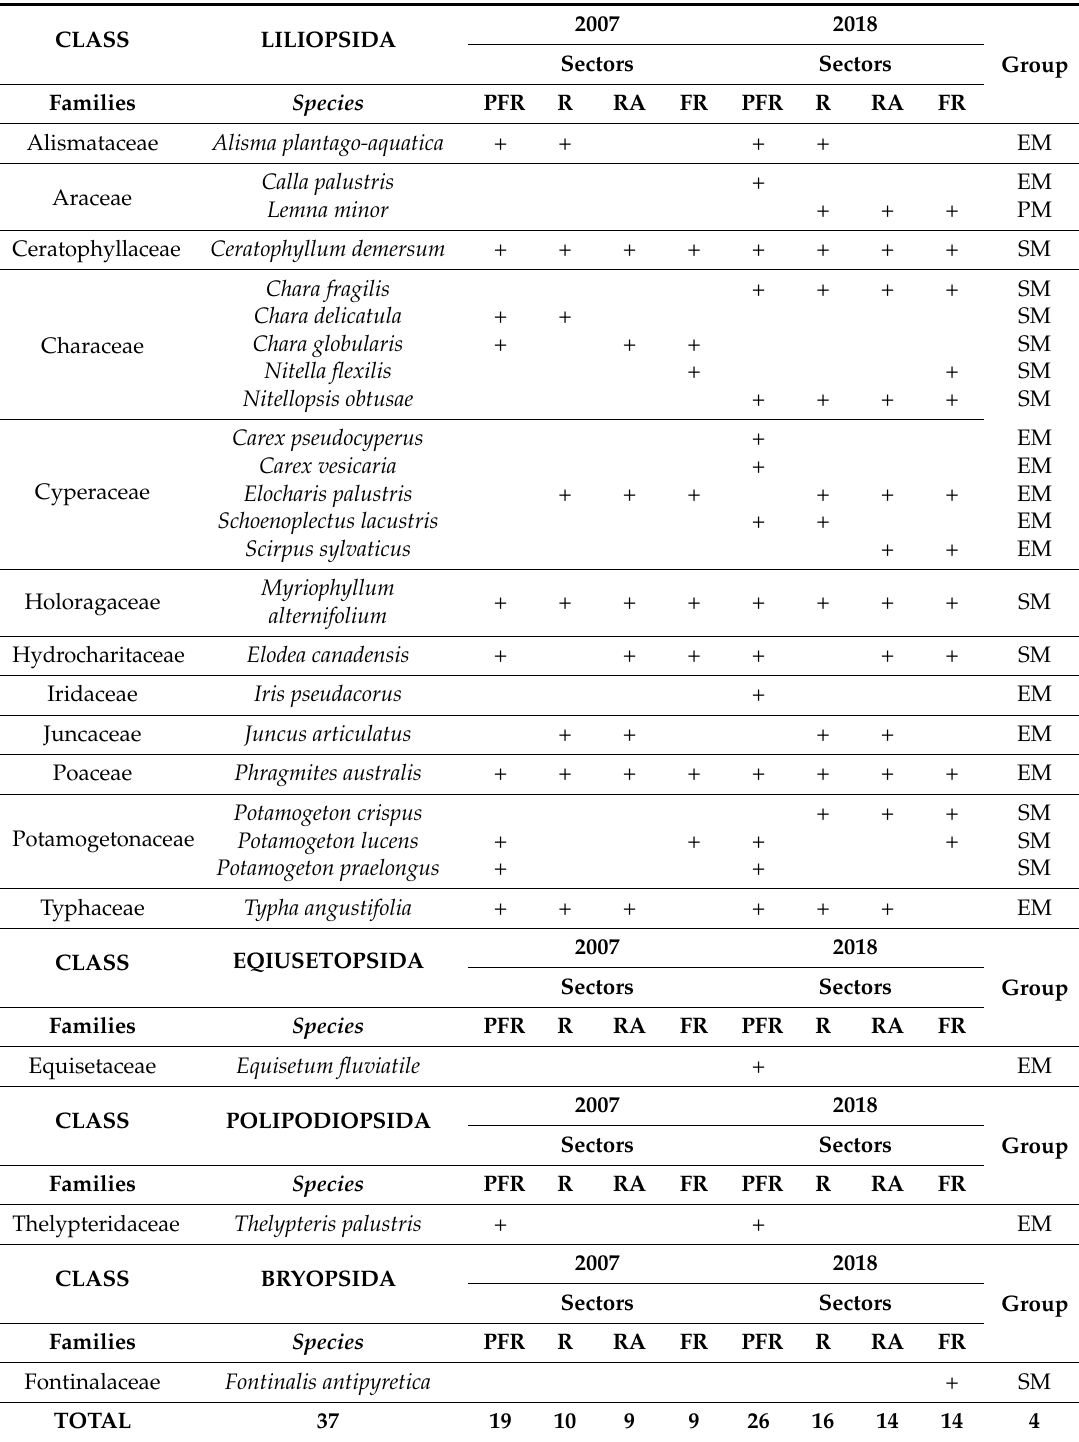
Table 8. The species composition of macrophytes of the littoral of Lake Piaseczno in 2007 and 2018 (EM, emerging macrophytes; SM, submerged macrophytes; FM, floating macrophytes; PM, pleuston